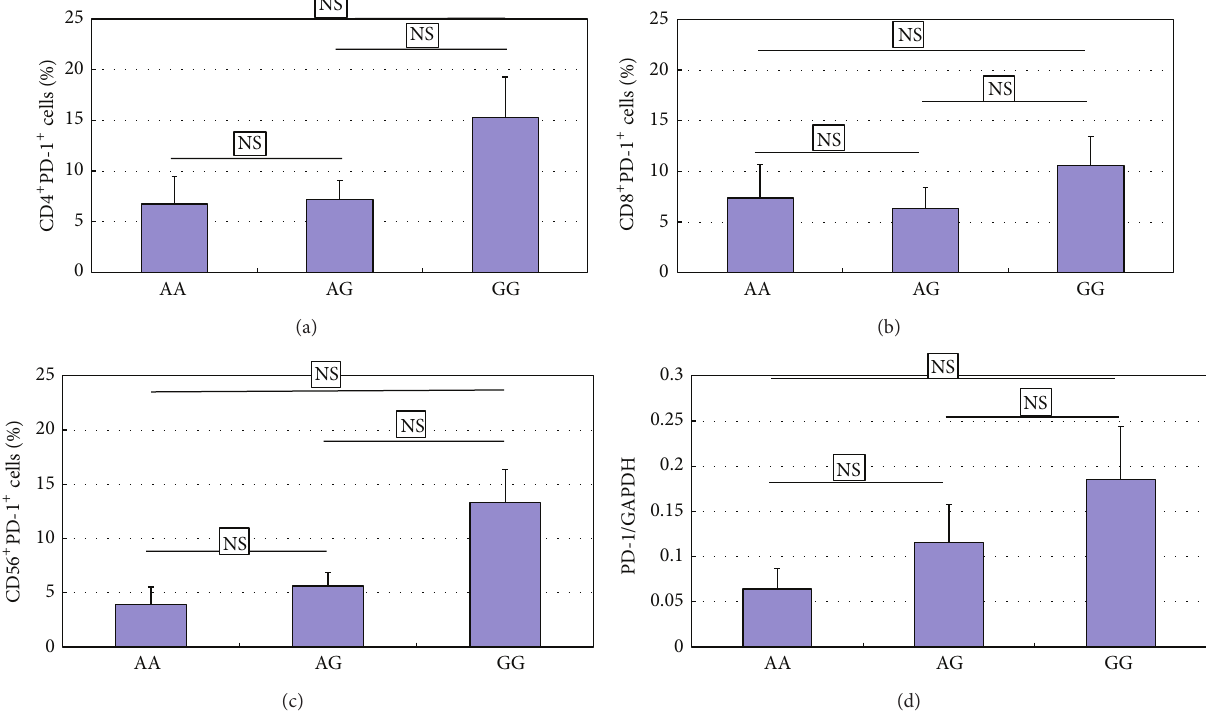
Figure 3: Analysis of PD-1 expression levels in SLE patients with different genotypes of rs36084323. Increased levels of PD-1 levels in PBMC of SLE ( 𝑛 = 30 ) patients, as compared with those from NC ( 𝑛 = 30 ). The patients with GG genotype ( 𝑛 = 11 ) exhibit higher PD-1 expression levels than those with AG ( 𝑛 = 15 ) and AA genotype ( 𝑛 = 4 ). Horizontal bars indicate the mean ±